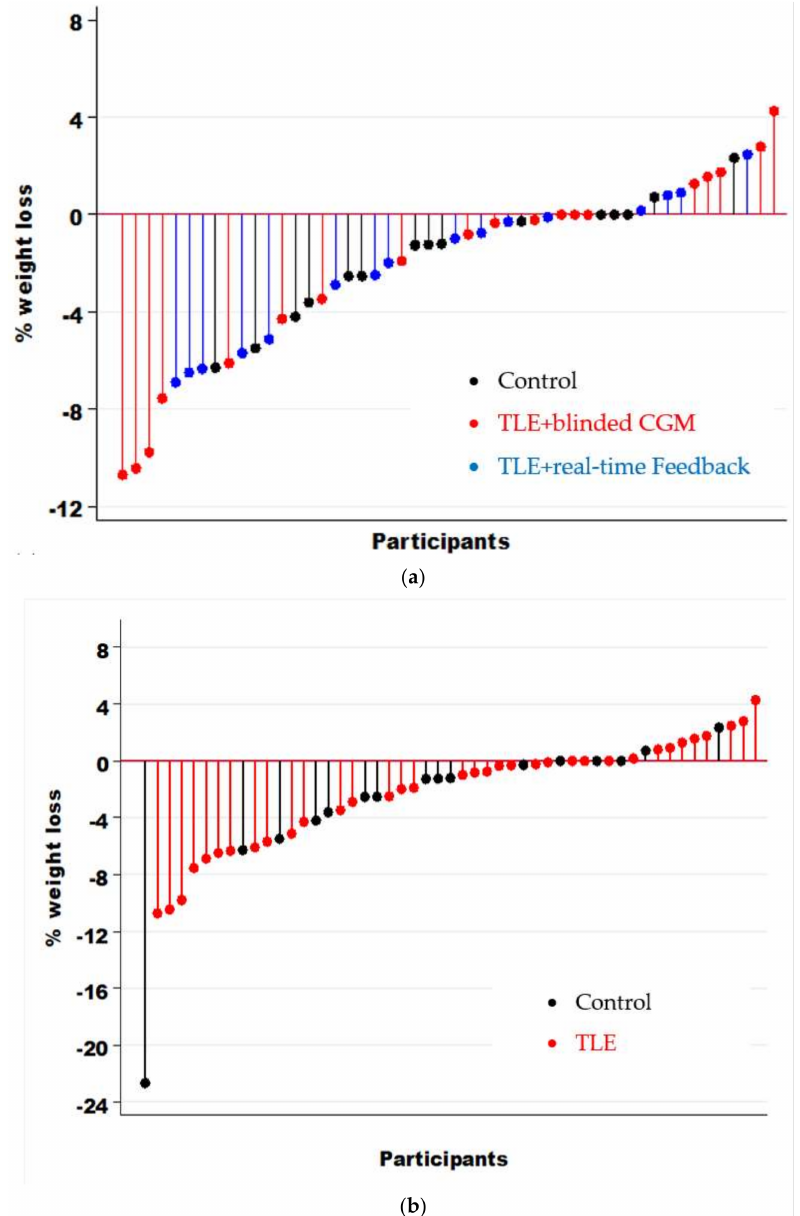
Figure 2. Percent weight loss at week 12 compared to baseline by individual participants across: ( a ) all three intervention arms and ( b ) TLE groups (TLE + blinded CGM and TLE + real-time CGM) compared to